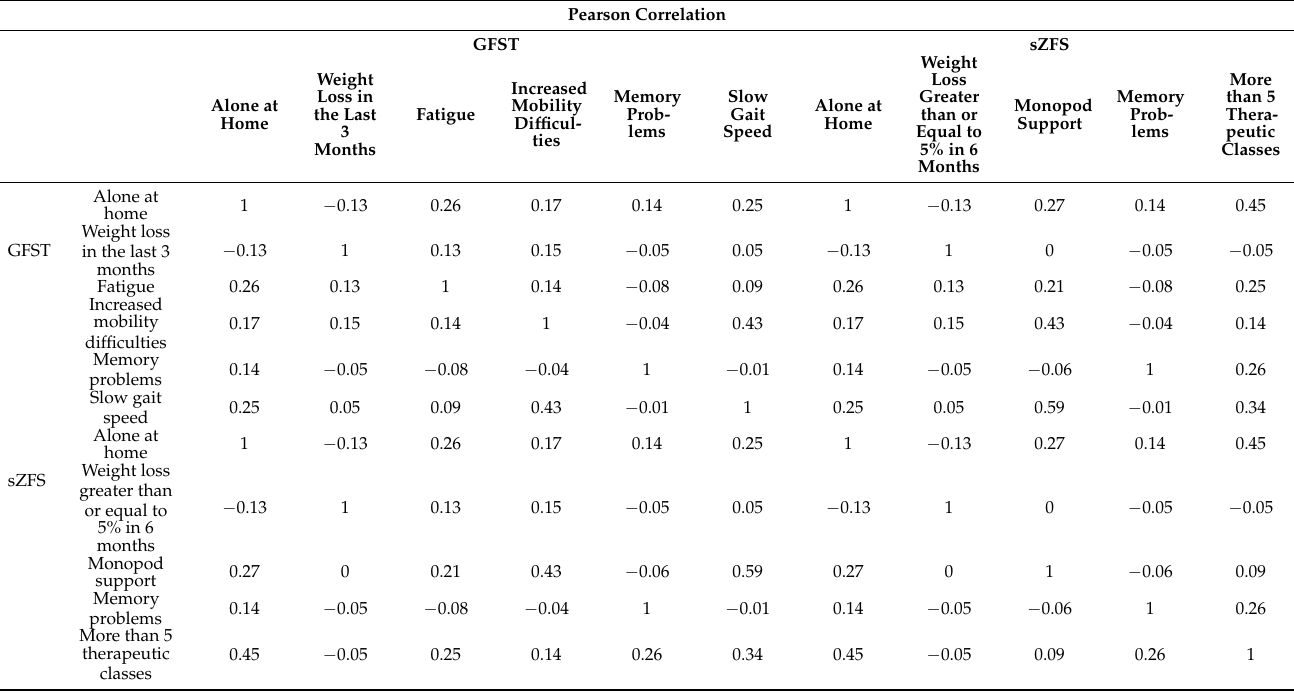
Table 5. Pearson correlation between the items of the two tools: “sZFS” and GFST’s criteria.